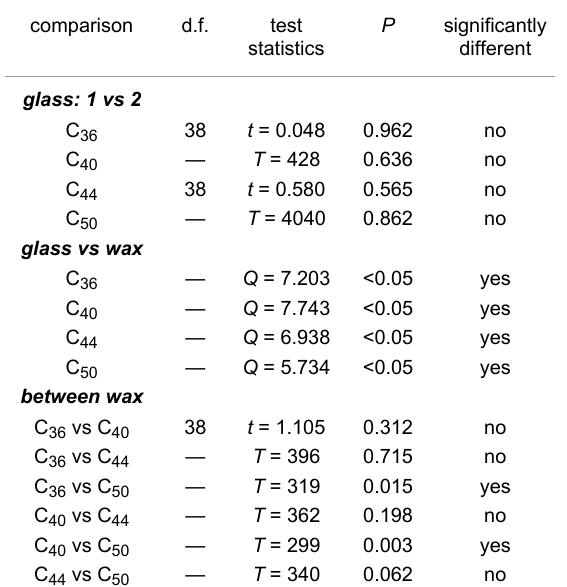
Table 3: Results of statistical analyses ( t -test, Mann–Whitney rank sum test, and Dunn’s method performed after Kruskal–Wallis one way ANOVA on ranks) of traction force values obtained on different samples. a different